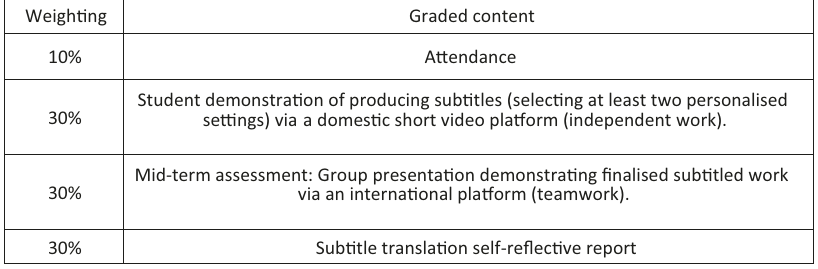
Fig. 6 Assessment of the subtitling course. This fi gure indicates the assessment of the Online Customisable AI-driven Subtitling Course.